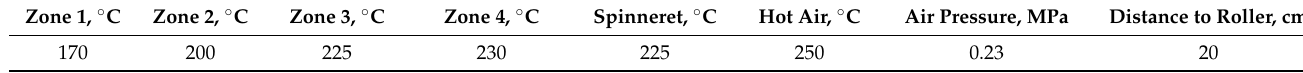
Figure 2. An illustration of the melt-blown process. Table 3. The main online parameters of melt-blown process.